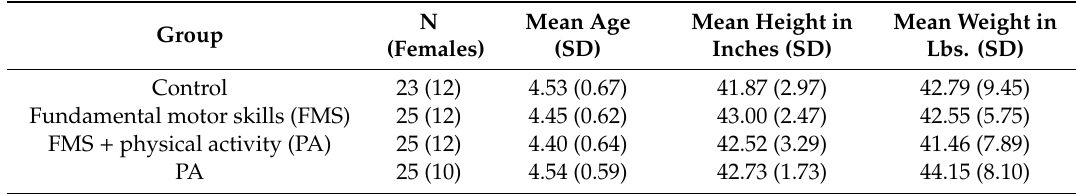
Table 1. Demographics [means and standard deviations